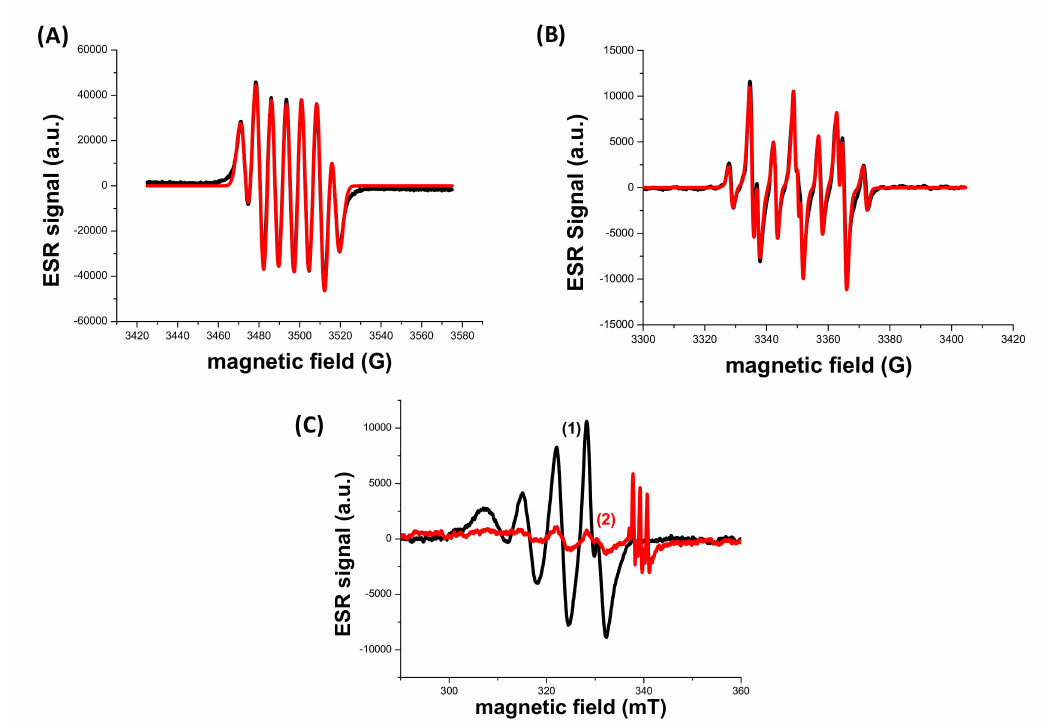
Figure 8. Electron Spin Resonance (ESR)-spin trapping experiment using [PBN] = 10 − 2 M (as spin trap agent); for the mixing of [DPS] = 10 − 1 M with ( A ) Mn(acac) 2 , ( B ) Cu(AAEMA) 2 simulated (red) and experimental (black) spectra, ( C ) Reduction of Cu (AAEMA) 2 ; (1) without DPS and (2) with DPS in tert-butylbenzene; under N 2